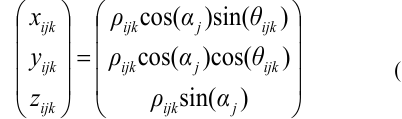
horizontal angular position (horizontal angle), respectively, and